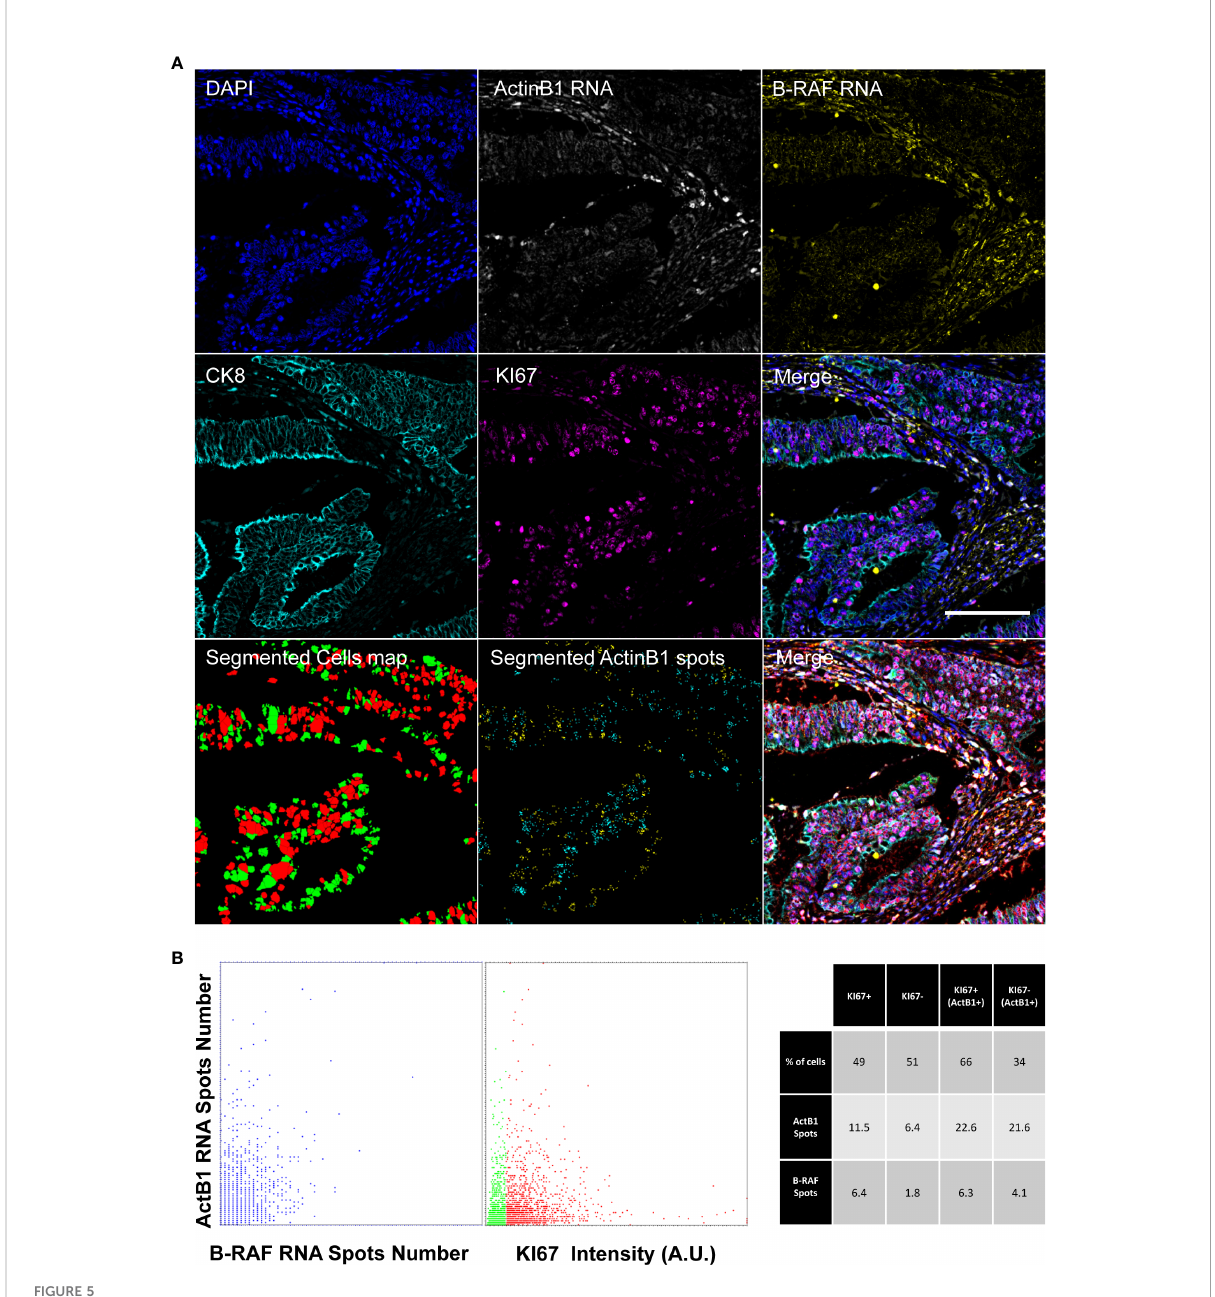
FIGURE 5 Diffraction-limited Image-Cytometry Analyis of a smRNA-FISH In-Situ hybridization. Images are collected with a 60x 1.4 Oil Immersion Objective to measure probe signals at maximum spatial resolution and sensitivity on a selected region inside a previously acquired core. Panel (A) : Images of DAPI, ActinB1 RNA, B_RAF RNA, CK8, KI67 (CK8, KI67 rescaled to the same digital resolution from the previously acquired 20x acquisition employed to target the selected ROI; scale bar: 200 m m) and the resulting Merge are shown together with the masks of the segmented cells (KI67+, Red; Ki67- Green) and of ActinB1 spots of the isolated cell populations (KI67+ Cyan spots; KI67- Yellow spots). Panel (B) : The Dot Plot on the left reports the number of detected RNA spots per cell: the correlated distribution shows comparable hybridization ef fi ciency for the two probes. In the Dot Plot the detected ActinB1 RNA spots number per cell are classi fi ed according to the KI67 content of the cell of origin(Red: KI67+; Green: KI67-). The table on the left shows a correlated analysis of KI67 content in relation to transcriptional activity (summarized by RNA spots number). Higher transcriptional acitivity (ActB1+), identi fi ed by an arbitrary threshold (>10) on ActinB1 spots evidences a link with the proliferating index. The proliferating fraction in this population is enriched (66% versus 49%) with respect to the entire cell